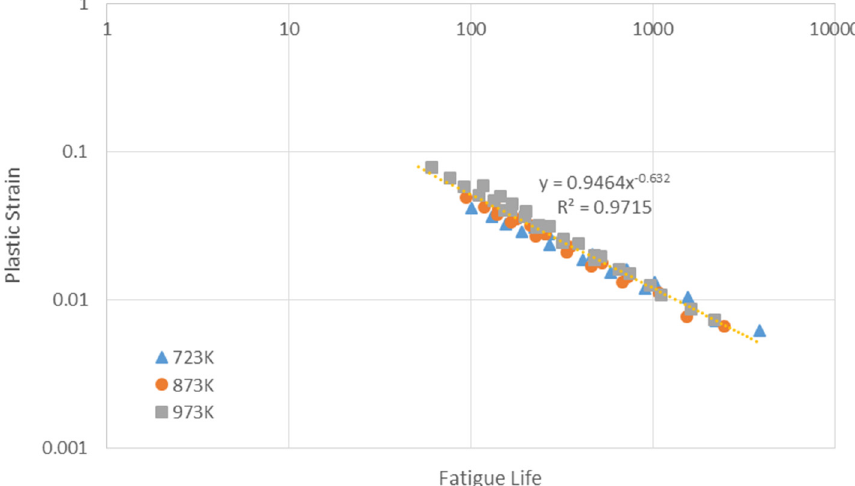
Figure 3. Transformed ε p, ref ‐ N data of stainless steel 316 using Equation (14) with creep function c ( T , t , ε p ).